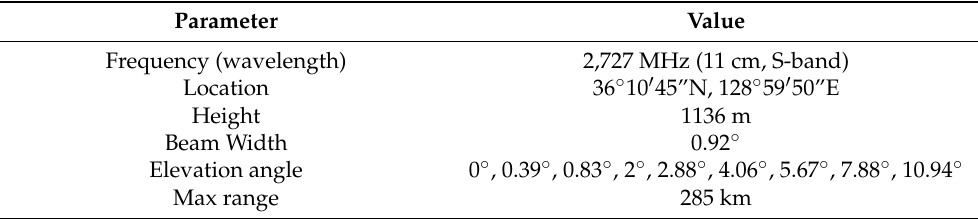
Table 1. Characteristics of the S-band dual-polarization radar at Mt. Myeonbong